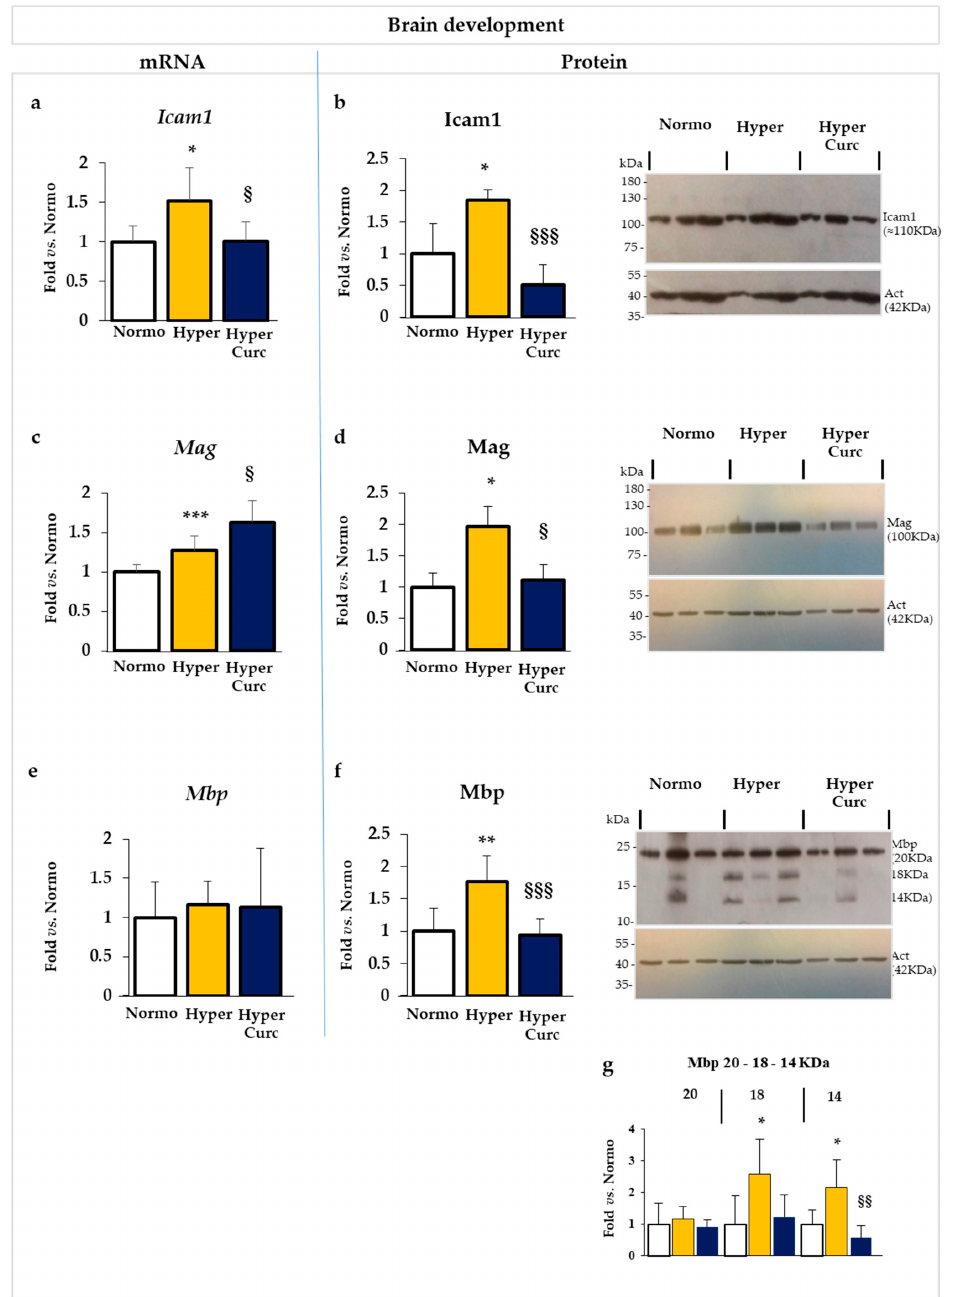
Figure 8. Curc normalizes the level of selected markers of brain development in the Hyper Gunn rat. The effect of Curc on the mRNA ( a , c , e ) and protein ( b , d , f , g ) level of Icam1 /Icam1 (intercellular adhesion molecule 1, Figure 8a,b), Mag /Mag (myelin-associated glycoprotein, Figure 8c,d), and Mbp /Mbp (myelin basic protein, Figure 8e,f,g), known to be altered in P17 Hyper pups, were evaluated by RTqPCR and Western blot, respectively. With white bars—untreated normobilirubinemic (Normo) Gunn pups; yellow bars—untreated hyperbilirubinemic rats (Hyper); blue bars—curcumin- treated hyperbilirubinemic pups (Hyper Curc). Data are in mean ± S.D. and expressed as fold vs. the Normo pups used as reference (=1). In each experimental group, ≥ 6 animals were studied. Statistical significance was evaluated by the one-way analysis of variance (ANOVA), followed by a Tukey–Kramer Multiple Comparisons Test when p -value < 0.05. Statistical significance: *, **, ***: p < 0.05, p < 0.01, p < 0.001: vs. Normo pups. §, §§, §§§: p < 0.05, p < 0.01, p < 0.001 vs. Hyper